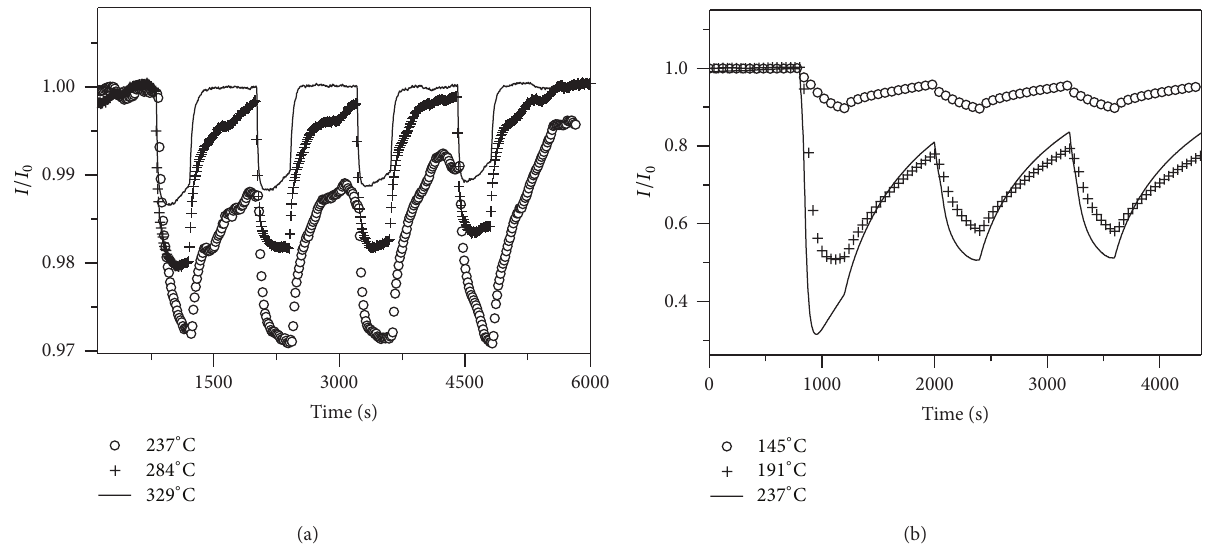
Figure 10: Normalized current sensing response of the MoO 3 microsensor to 8% of CO 2 under different temperatures (329 ∘ C—open circles; 284 ∘ C—crosses; and 237 ∘ C—continuous line) (a) and to 1.7% of H 2 under different temperatures (237 ∘ C—open circles; 191 ∘ C—crosses and; and 145 ∘ C—continuous line) (b) test gases in a commercial N 2 (dry air).